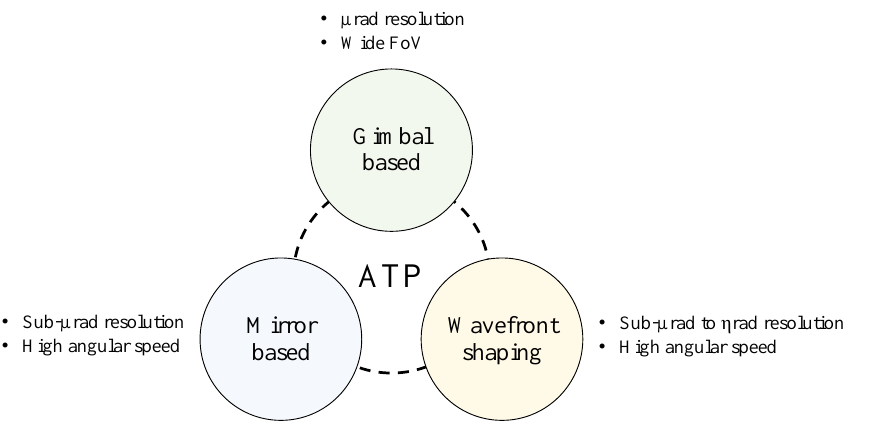
Figure 1. Classification of ATP mechanisms in FSO communications according to their working principle and use